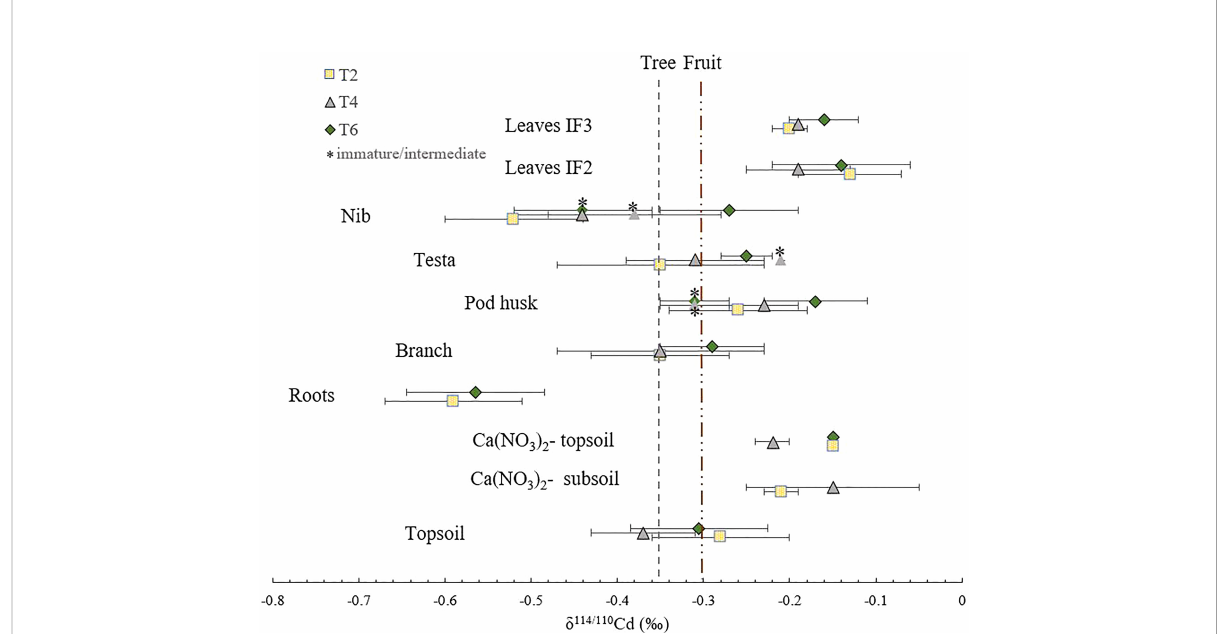
FIGURE 1 Cd isotope composition for the various organs in three trees (T2, T4 and T6). The fi rst dashed line on the left represents the weighted average isotope composition of the whole cacao tree ( d 114/110 Cd = -0.35 ± 0.02 ‰ ( n =2, biological SD)). The second dashed line represents the weighted average isotope composition of the cacao fruits ( d 114/110 Cd = -0.35 ± 0.05 ‰ ( n =5, biological SD)). For the fruit tissues, the mature, intermediate and immature stages are indicated by depicting the immature and intermediate stages with a *. Error bars represent 2 x standard